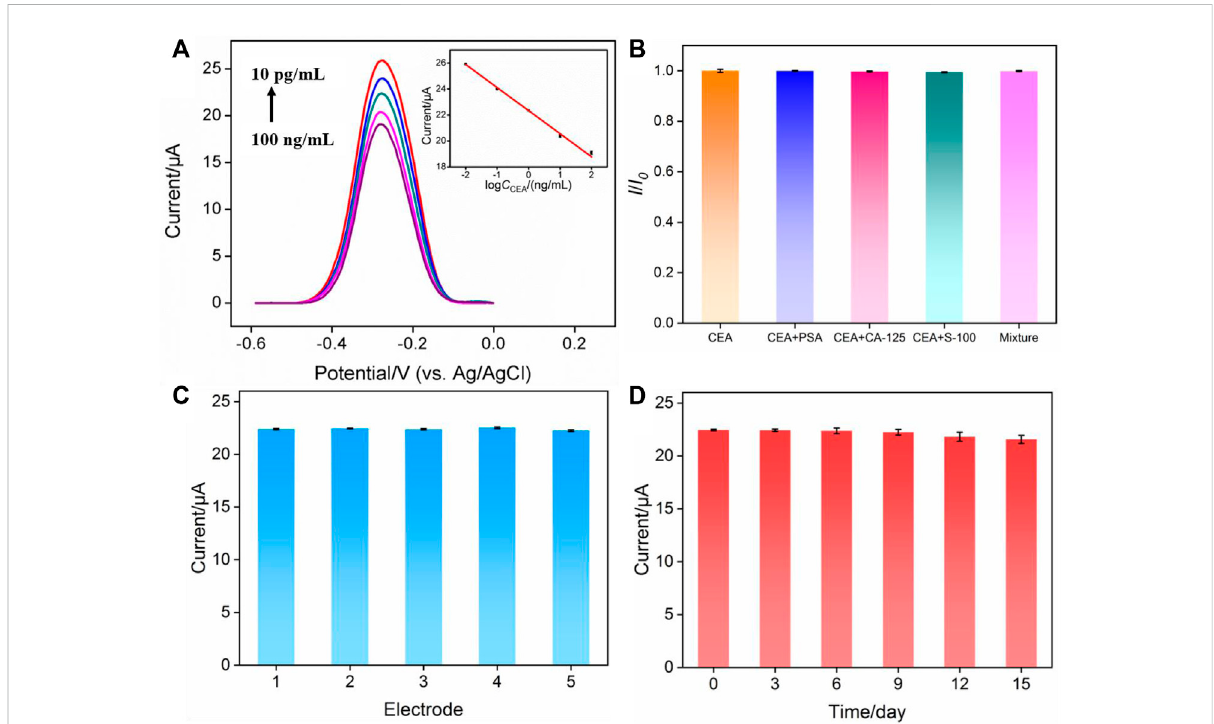
FIGURE 6 (A) Electrochemical response of the immunosensor in presence of different concentrations of CEA. Inset is the calibration curve for the determination of CEA. (B) Relative ratio of peak current before ( I 0 ) and after ( I ) incubation with CEA, CEA + PSA, CEA + CA125, CEA + S-100 or the mixture containing CEA, PSA, CA125, S-100. The concentration of CEA and other proteins are 0.1 ng/ml and 10 ng/ml, respectively. (C) The peak current obtained using fi ve different electrodes. (D) The peak current obtained using electrodes stored for different